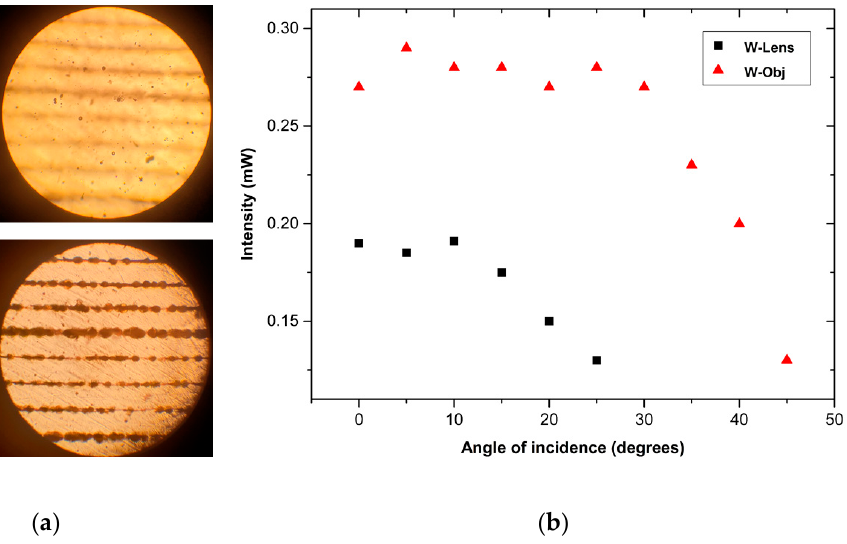
Figure 3. ( a ) Optical microscope image of a W-Obj processed phosphate glass focused on its surface (top) and 300 μ m below the surface (bottom). For scale illustration purposes please consider SEM photos. ( b ) Intensity of the transmitted light versus incident angle.